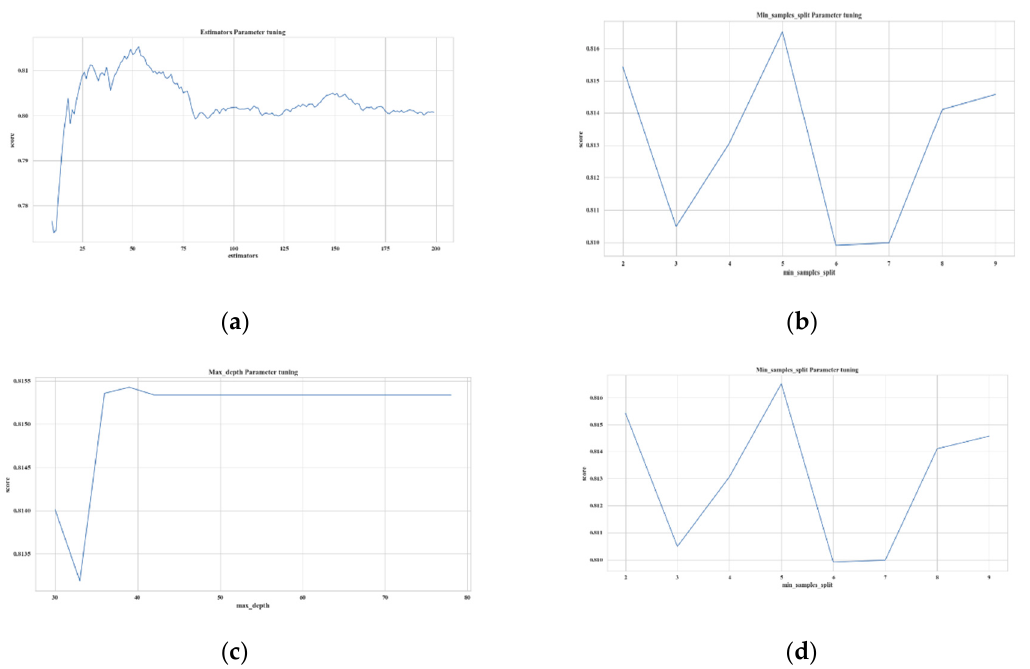
Figure 3. Model hyperparameter determination. ( a ) Estimators = 197.0. ( b ) Min_samples_split = 2.0. ( c ) Max_depth = 16.0. ( d ) Min_samples_leaf =